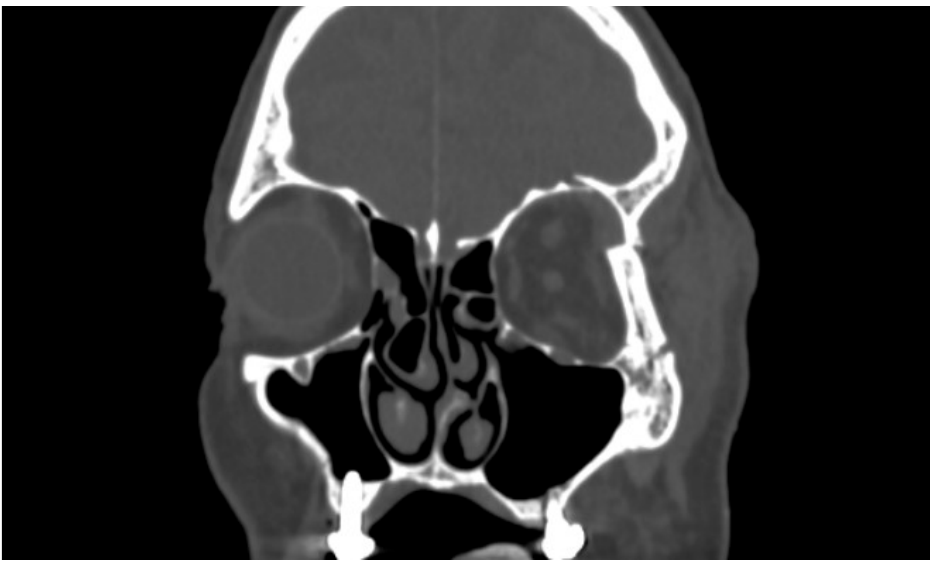
Figure 1. CT scan of a case of diplopia in a patient with a lateral orbit wall fracture.